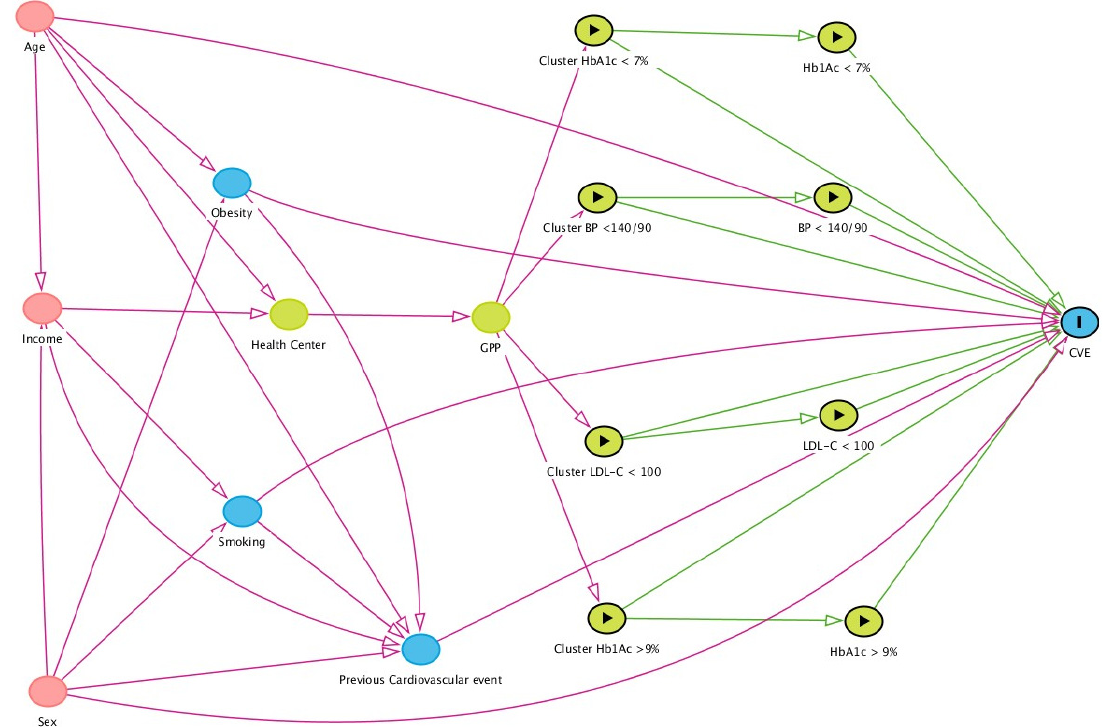
Figure 1. Directed acyclic graph (DAG) of the effect of the cluster of HbAc1 ≥ 9% (exposure) on cardiovascular events (outcome). Ancestors of exposure and outcome , ancestors of outcome , ancestors of exposure , exposure , and outcome . Based on DAGitty version 3.0.